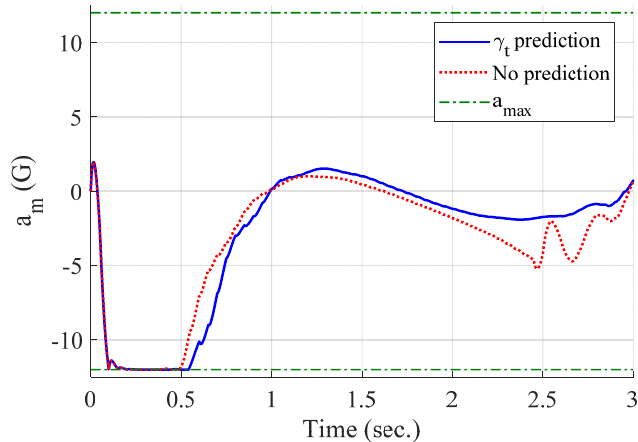
Figure 6. Acceleration of the missile (single-run